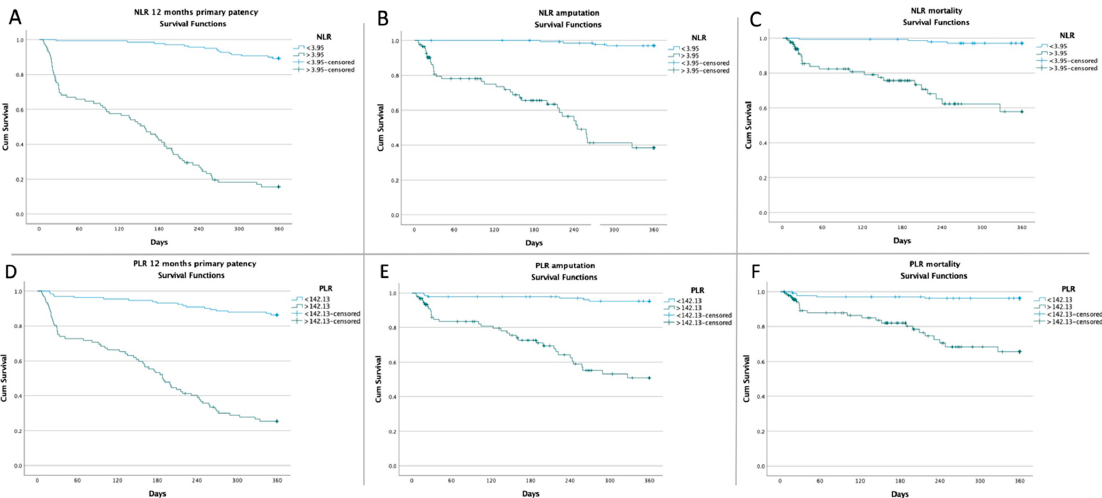
Figure 4. Kaplan–Meier curves showing ( A ) 12 months primary patency probability according to NLR optimal cut-off value ( p < 0.001; log-rank p), ( B ) amputation probability according to NLR optimal cut-off value ( p < 0.001; log-rank p), ( C ) mortality probability according to NLR optimal cut-off value ( p < 0.001; log-rank p), ( D ) 12 months primary patency probability according to PLR optimal cut-off value (p < 0.001; log-rank p), ( E ) amputation probability according to PLR optimal cut-off value ( p < 0.001; log-rank p), and ( F ) mortality probability according to PLR optimal cut-off value ( p < 0.001; log-rank